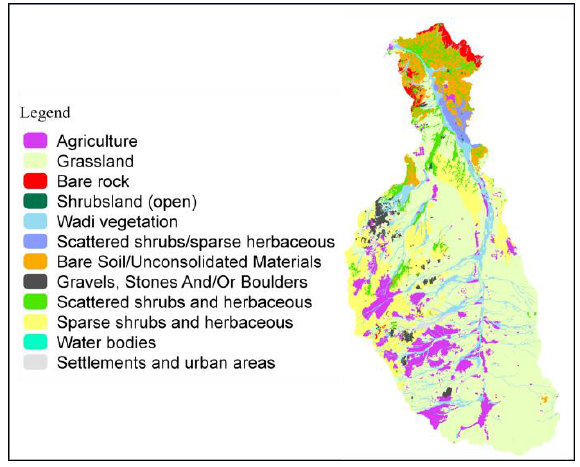
Landcover map of Wadi El Hawad catchment